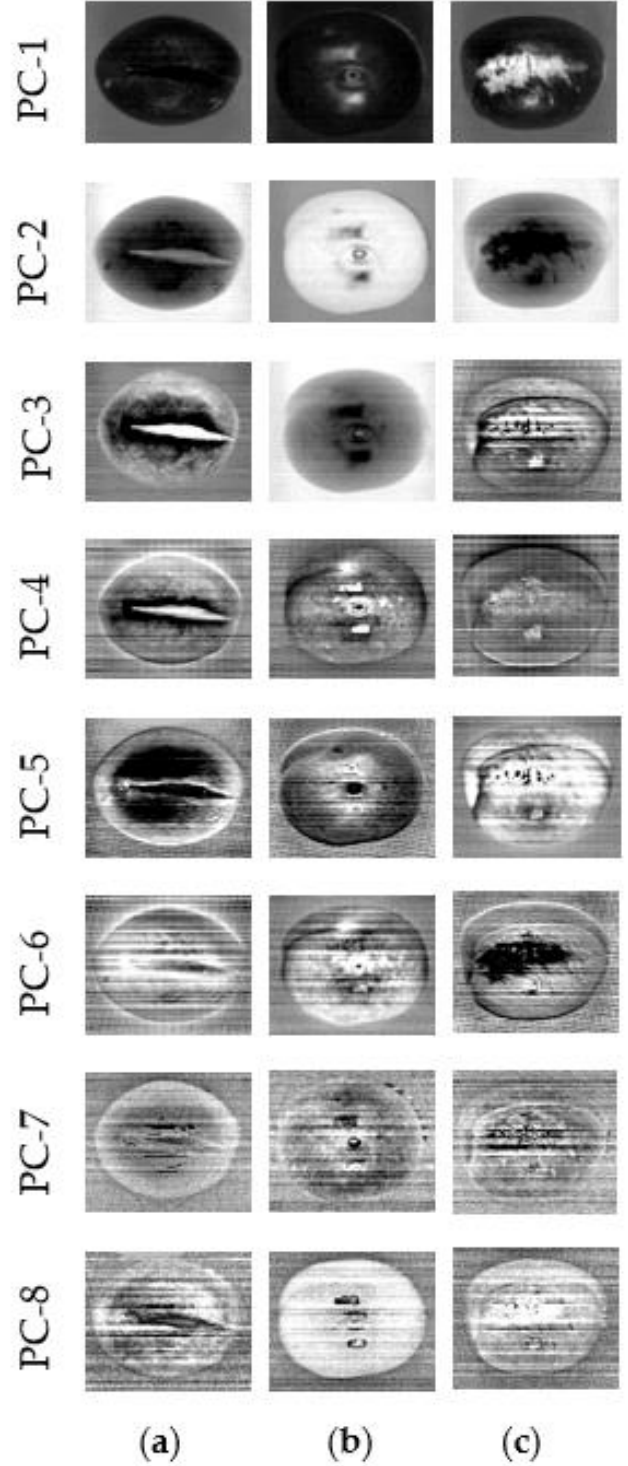
Figure 8. The first eight PCs grayscale image of defect feature of Cerasus humilis fruit samples: ( a ) Crack sample; ( b ) Insect damage sample; ( c ) Rust spot sample.